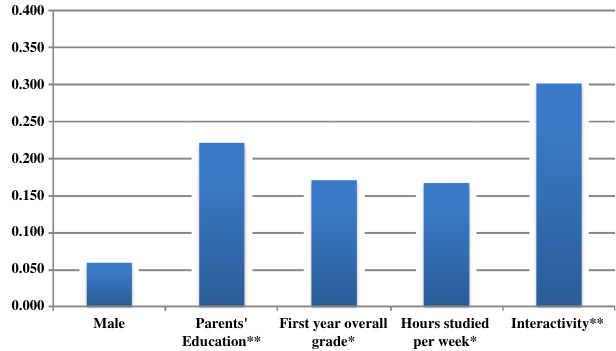
FIG. 4 (color online). Standardized coefficients for model 3 with E&M common final exam problem score as the dependent variable (from Table VI) (* p < 0 : 05 , ** p < 0 : 01